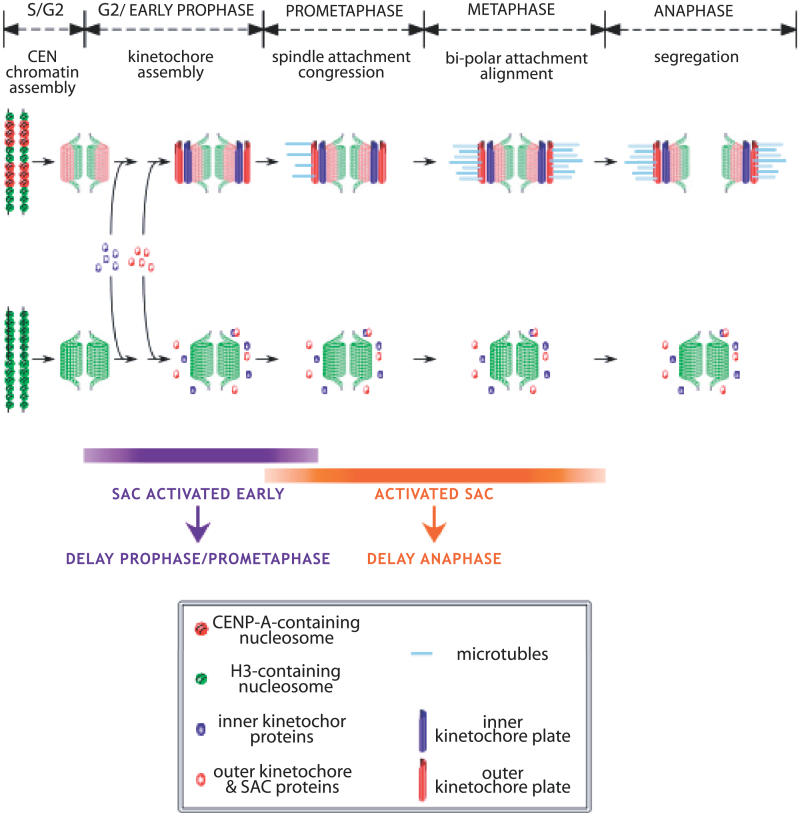
SAC Components Affect Cell Cycle Progression in the Absence of Kinetochore LocalizationIn normal cells, CENP-A chromatin assembly is followed by the recruitment of inner and outer kinetochore proteins [17]. We propose that until kinetochore assembly is complete, free SAC components may be responsible for cell cycle inhibition (early activation of the SAC). Upon completion of kinetochore assembly, SAC components delay anaphase until all chromosomes have achieved bipolar spindle attachment. In cid null mutants, both inner and outer kinetochore proteins are free, resulting in a SAC-dependent early mitotic delay that does not depend on localization of SAC components to kinetochores.